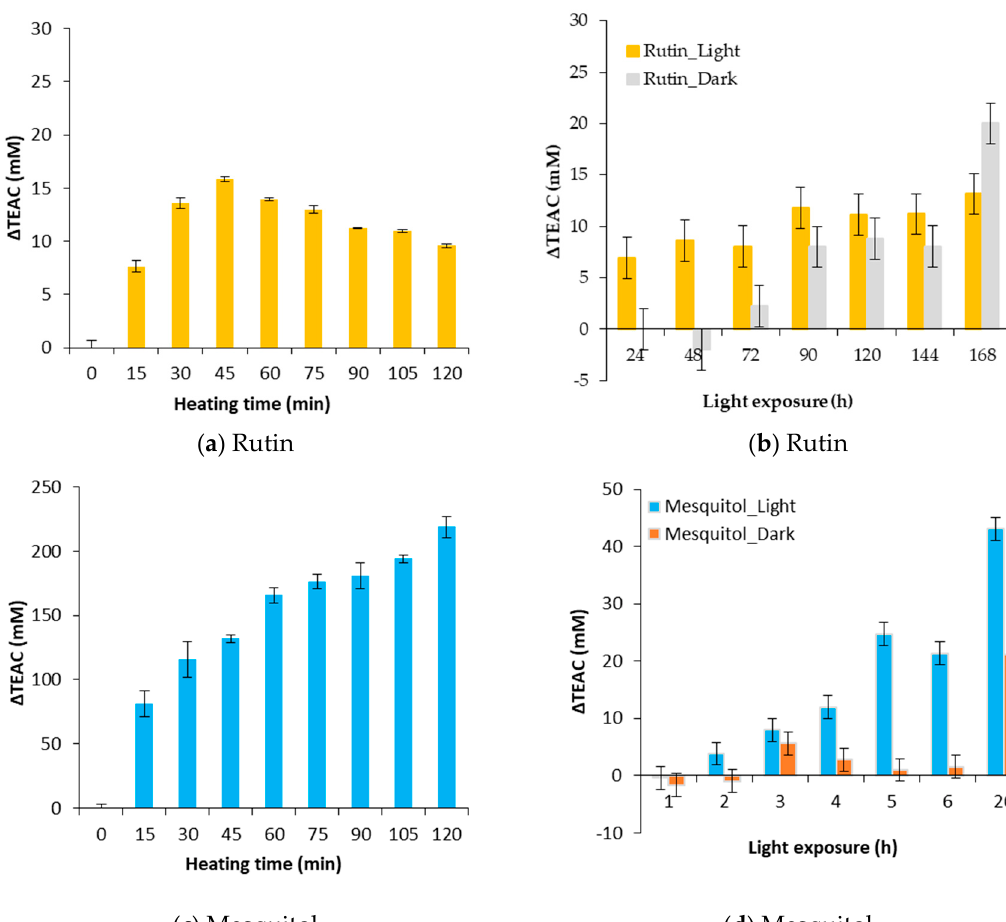
Figure 5. Evolution of Δ TEAC for a thermal treatment of 130 °C ( a , c ) and an exposure to light ( b , d ) for rutin ( a , b ) and mesquitol ( c , d ).